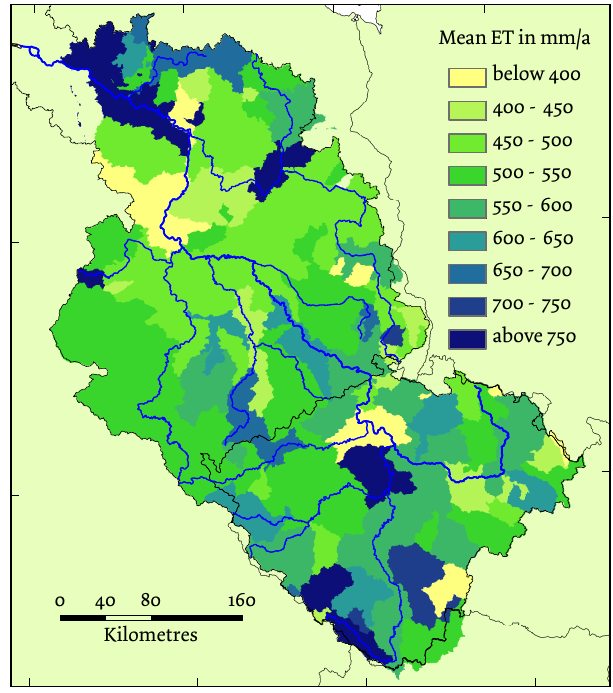
Fig. 11. Evapotranspiration patterns in the Elbe River basin accord- ing to the water balance. Average values for 133 sub-basins for the years